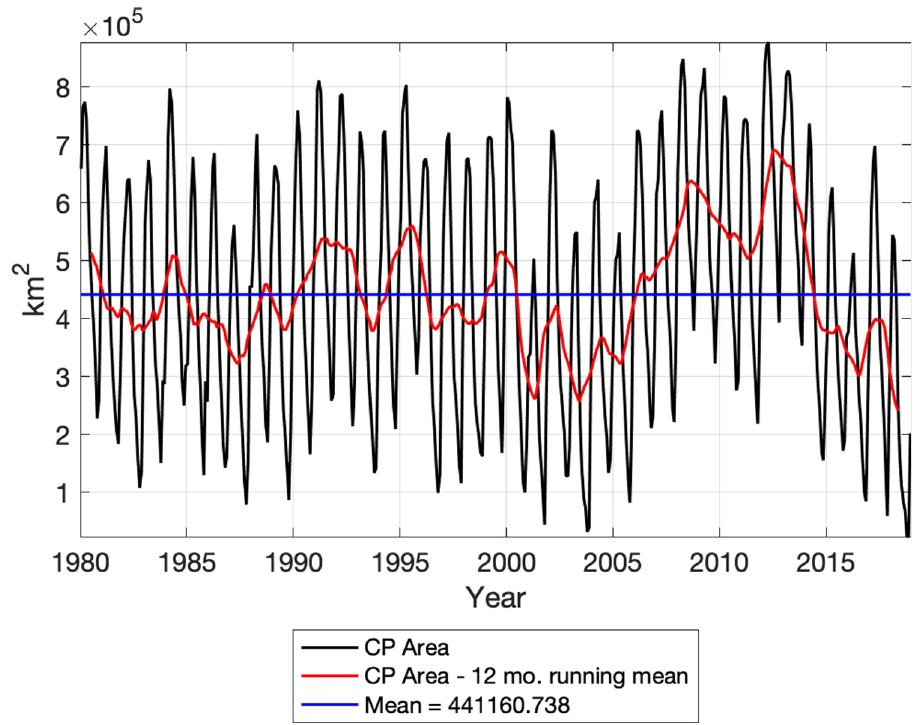
Fig 2. Monthly mean Cold Pool area. Cold Pool area (km 2 ; black), 12-month running mean of the Cold Pool area (km 2 ; red) and the long-term mean (km 2 ; blue) from RASM during 1980–2018.